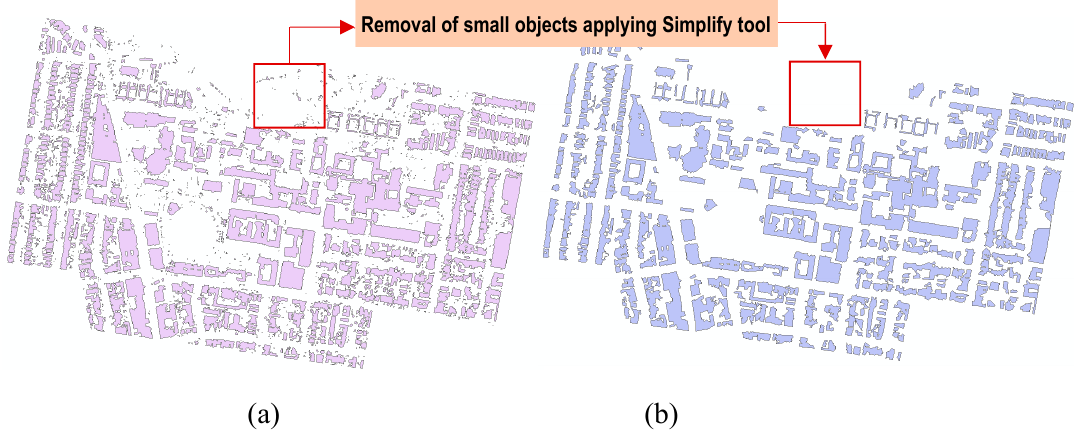
Figure 13. Result from using Aggregate Points tool ( a ) and Simplify building tool with assigning 100 m 2 for min area and value of 1 for simplification tolerance ( b ) for UNSW data set.